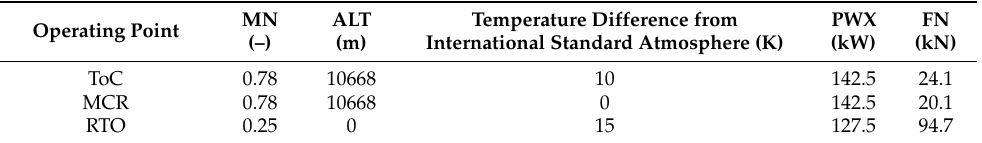
Table 1. Top-level aircraft